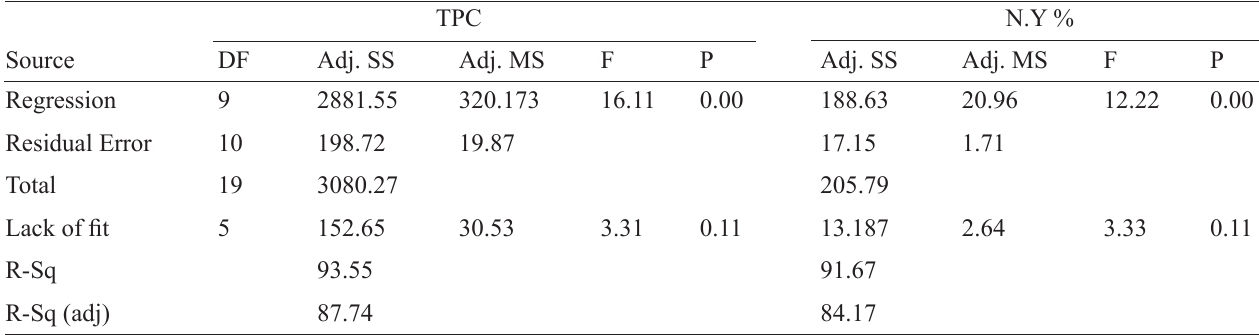
Table 3. Summary table of analysis of variance for TPC and NY